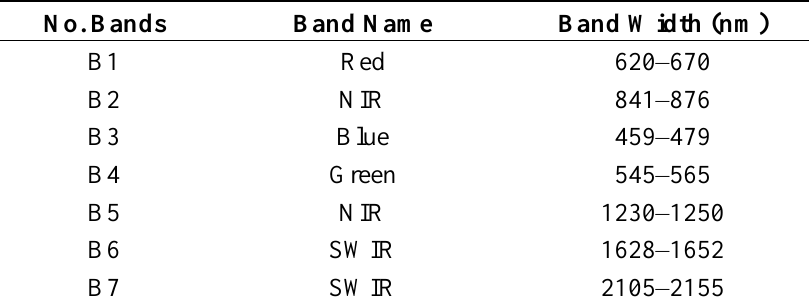
Table 1. MODIS surface reflectance bands.